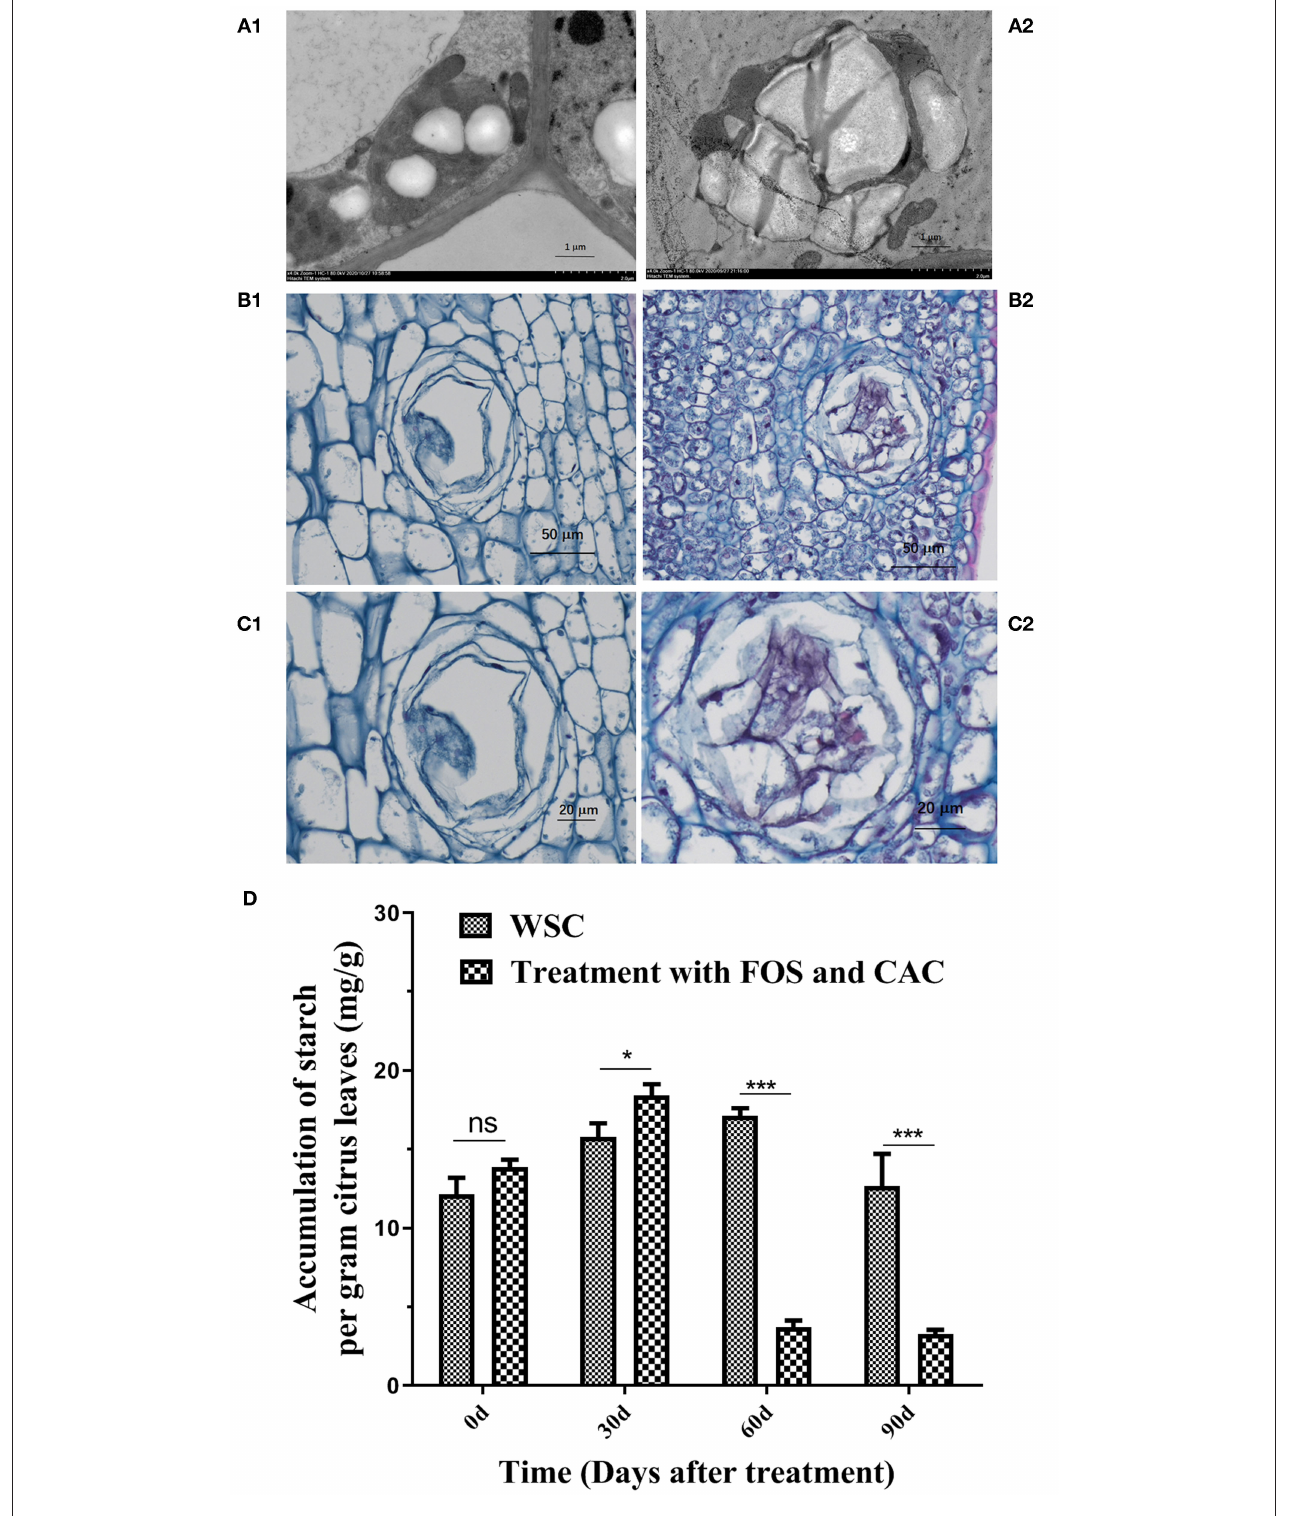
FIGURE 6 | Starch accumulation on HLB-infected citrus leave and was reduced after FOS and CAC treatment. (A) TEM images of citrus leaves. A1: healthy leaves; A2: HLB-infected leaves. (B) PAS and phenol yellows dyeing of citrus leaves. B1: healthy leaves; B2: HLB-infected leaves. (C) The secretory tissues of citrus leaves in partial enlargement of (B) . C1: healthy leaves; C2: HLB-infected leaves. (D) The changes of starch accumulation during FOS + CAC combination treatment 90 days. Asterisk indicates significant differences during FOS + CAC combination treatment 90 days (Student’s t -test, * p < 0.05, *** p < 0.001), ns indicated no significant